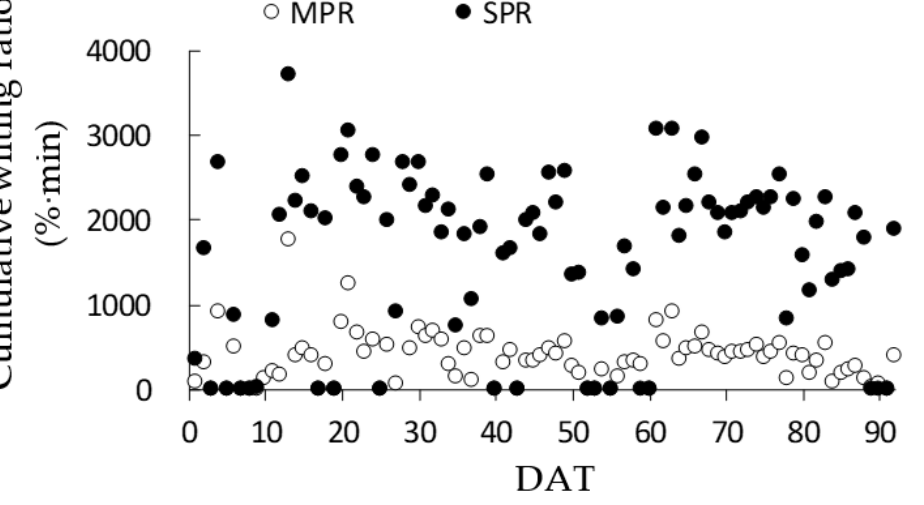
Figure 2. Cumulative wilting ratio during a 92-day experimental period. MPR: moderate wilting–partial recovery treatment. SPR: severe wilting–partial recovery treatment. DAT: days after the start of treatments. Table 2. Irrigation amount and frequency during a 92-day experimental